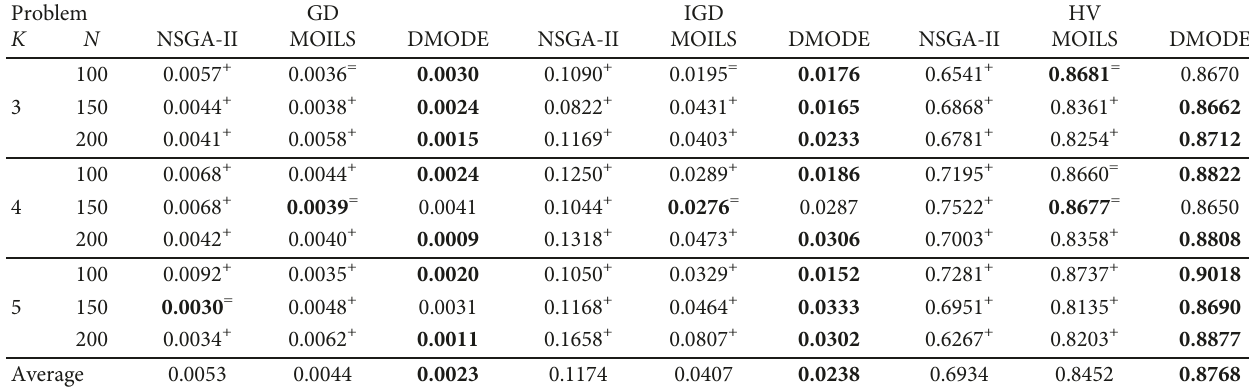
Table 3: Performance metrics obtained by NSGA-II, MOILS, and DMODE for random problems.